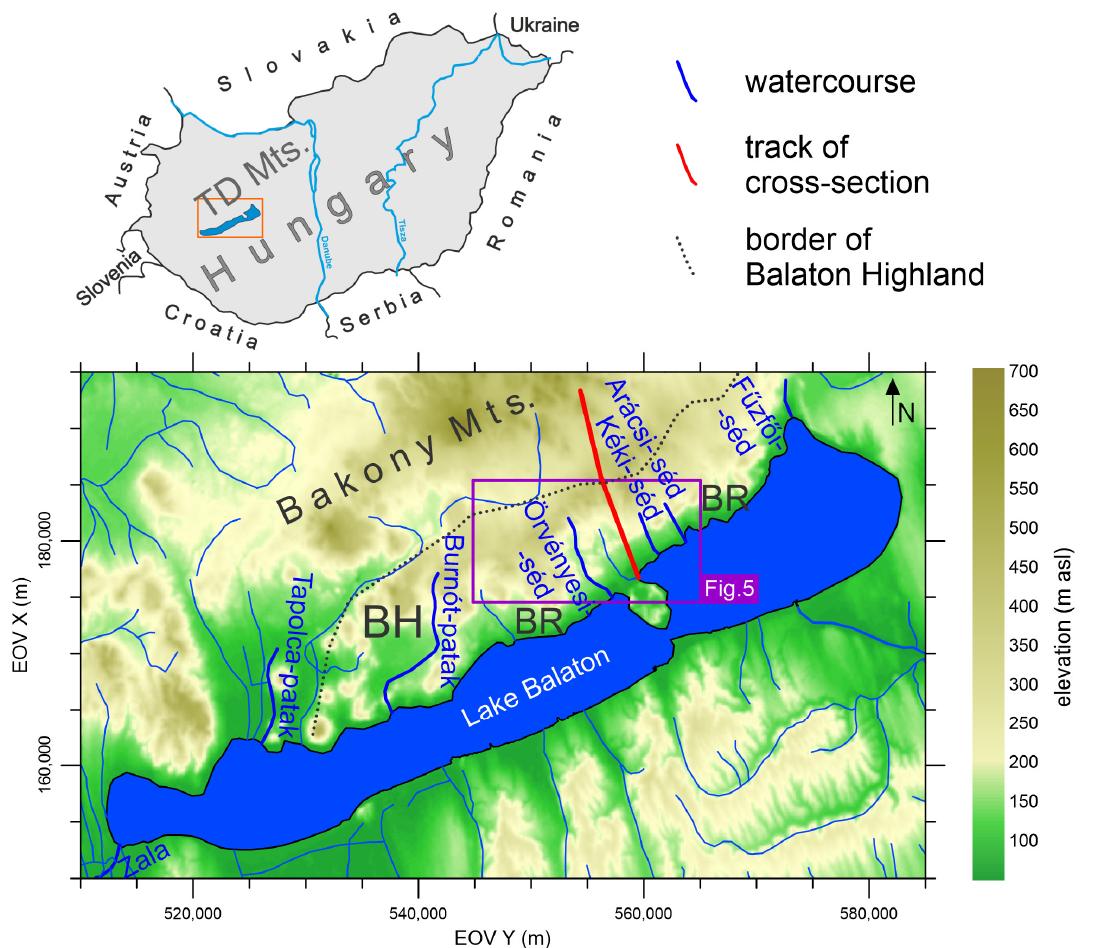
Figure 1. Location of the study area. TD Mts.—Transdanubian Mountains, BH—Balaton Highland, BR—Balaton Riviera (EOV is the Hungarian National Grid, a transverse Mercator projection, in which a positive X indicates north and positive Y indicates east. The numbers refer to metres.)